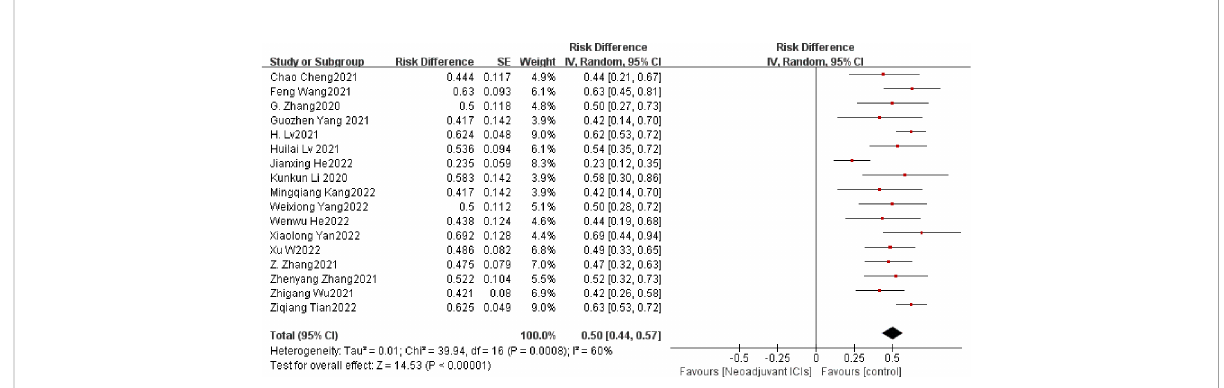
FIGURE 3 MPR neoadjuvant immunochemotherapy ef fi cacy forest plot. By de fi nition, an OR < 1 implies a therapeutic advantage of neoadjuvant immunochemotherapy for locally advanced esophageal cancer. MPR, a major pathological response; PCR, a pathological complete response; ICIs, immune checkpoints inhibitors; IV, inverse variance; CI, con fi dence interval; OR, odds ratio.